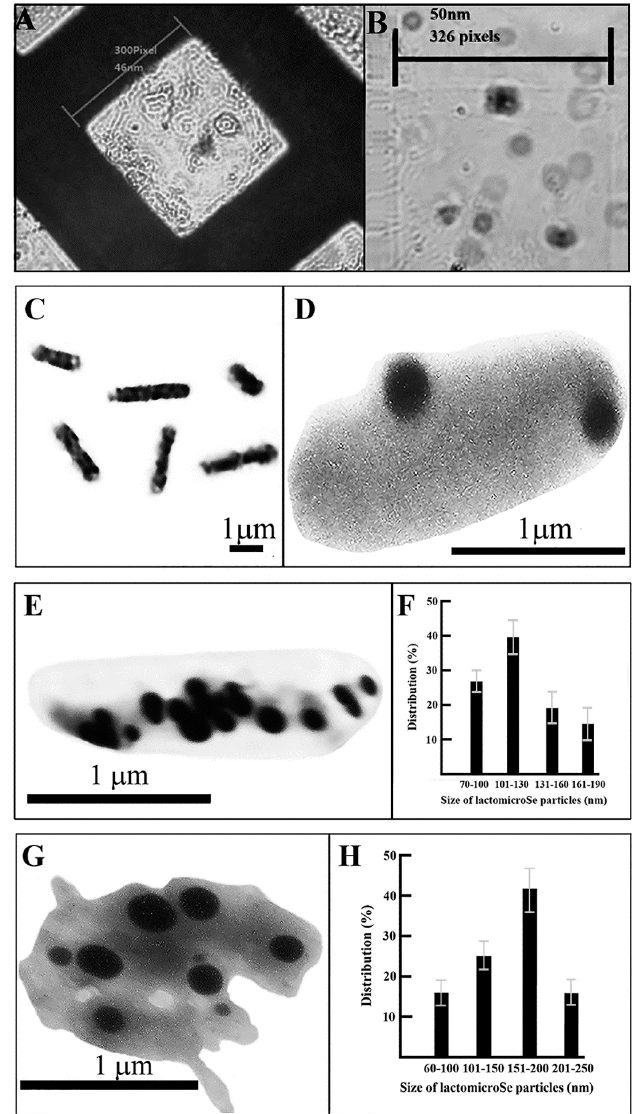
Figure 4. Transmission electron microscopy of lactomicroSel particles. Fermentation by probiotic yogurt bacteria ( L. acidophilus , L. casei , and S. thermophilus ) in the presence of sodium selenite was as decribed [2]. The lactomicroSel-containing bacilli were subjected to internet electron microscopy (iTEM). ( A ) Calibration of the transmission electron microscope. Individual squares of the TEM grid with an edge of about 300 pixels wide corresponded to 46 nm; ( B ) the edge of the small square in the Bürker chamber used for the measurement was 50 nm (326 pixels, 1 nm = 6.52 pixels), determined by the ImageJ software program; ( C ) light microscopy of L. acidophilus after fermentation and Gram staining; ( D ) lactomicroSel in a L. acidophilus ; ( E ) iTEM of L. casei containing lactomicroSel nanoparticles; ( F ) size distribution of lactomicroSel particles in L. casei ; ( G ) iTEM of disrupted S. thermophilus containing lactomicroSel particles; and ( H ) size distribution of lactomicroSel particles in S. thermophiles.